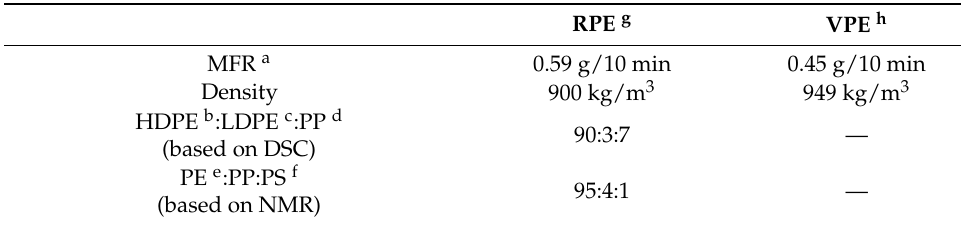
Table 1. Characteristics of pellets used in this study.